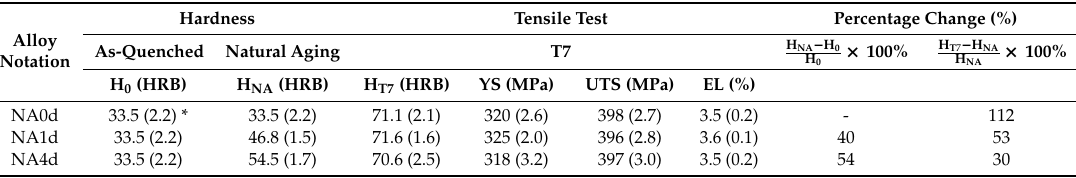
Table 4. Mechanical properties of alloys under di ff erent heat treatment conditions.